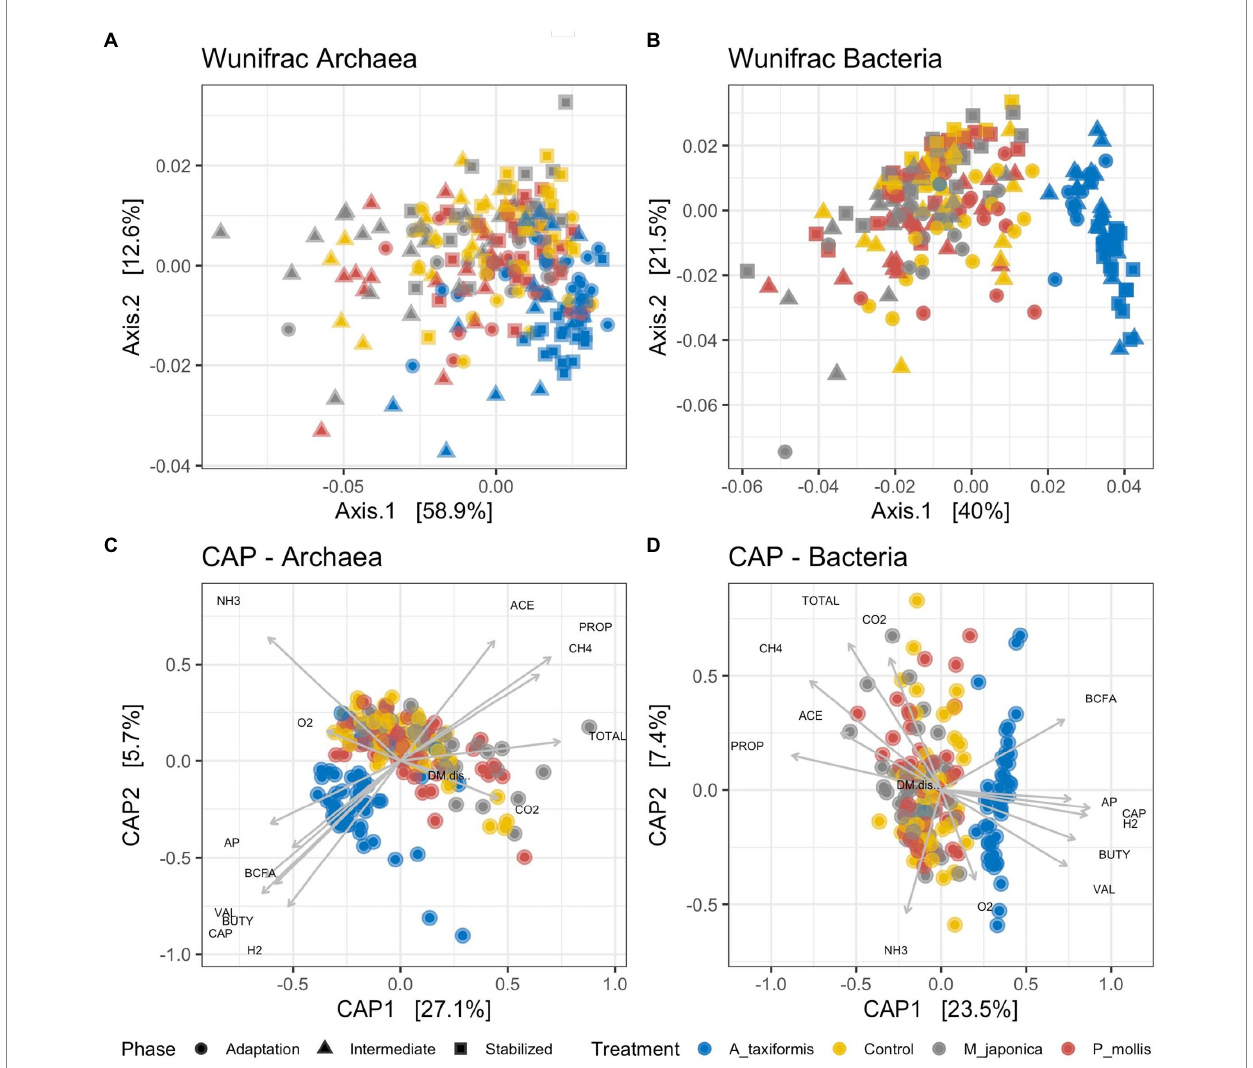
FIGURE 2 Unconstrained principal coordinate analysis (PCoA) plots based on rarefied Weighted Unifrac distance matrices for (A) archaeal and (B) bacterial communities. Constrained canonical analysis of principal coordinates (CAP) plots for (C) archaeal and (D) bacterial communities and environmental variables. The vectors indicate the axis that is best explained by each variable. Data was generated using Weighted Unifrac distance matrices. ACE, acetate; PROP, propionate; CH4, methane; TOTAL, total VFA; CO2, carbon dioxide; BCFA, branched-chain fatty acids; AP, acetate: propionate ratio; CAP, Caproate; H2, Hydrogen; BUTY, butyrate; VAL, valerate; O2, oxygen; NH3, ammonia. Individual sample values for all measurements are provided in the Supplementary material.